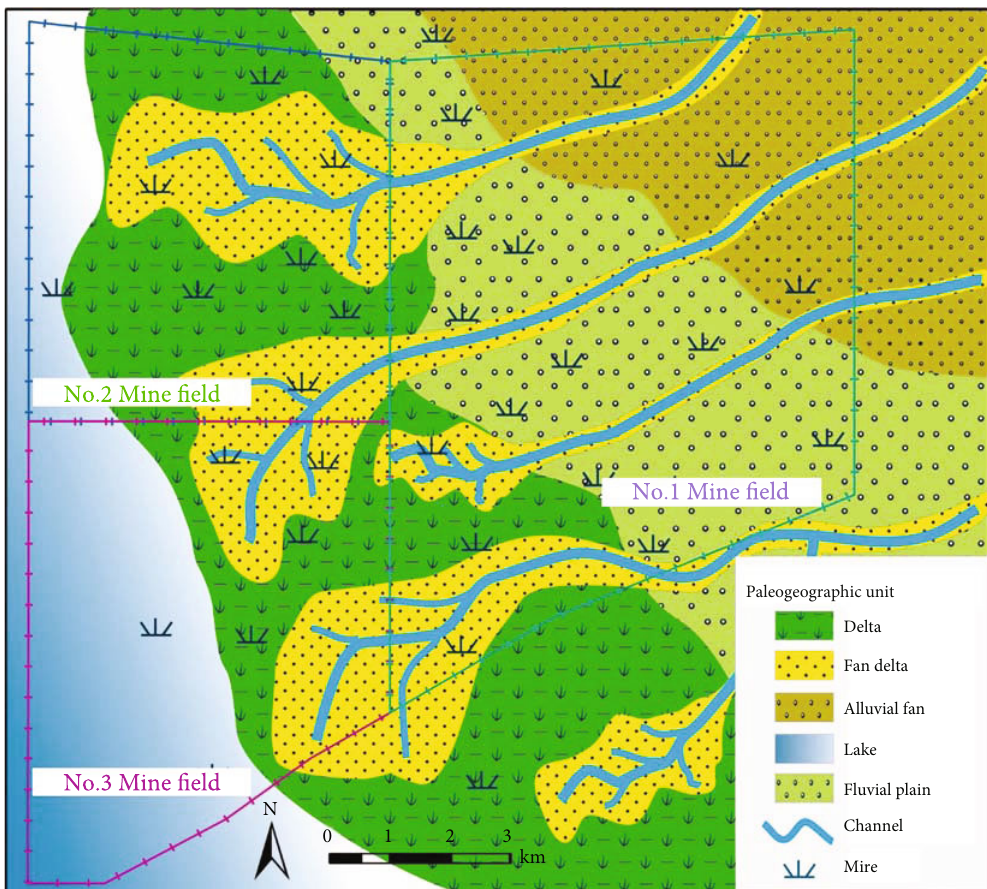
Figure 4: Lithofacies paleogeography of the middle member of Xishanyao Formation in western Dananhu coal fi